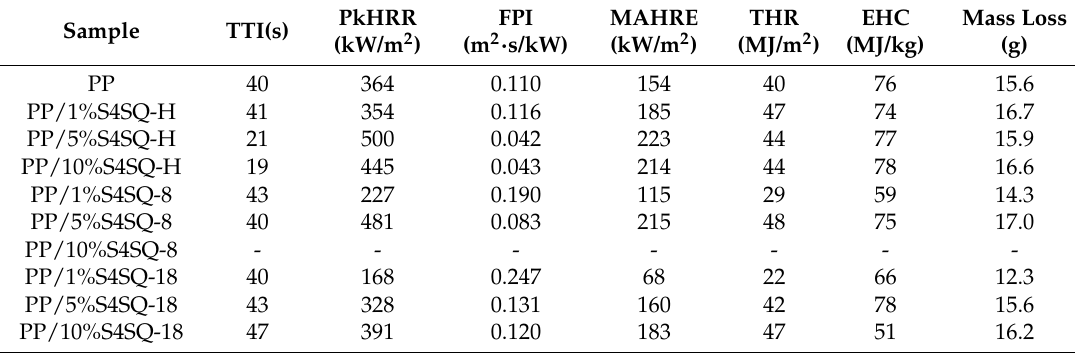
Table 2. Main parameters obtained from cone calorimeter measurements for neat PP and PP/S4SQ composites.